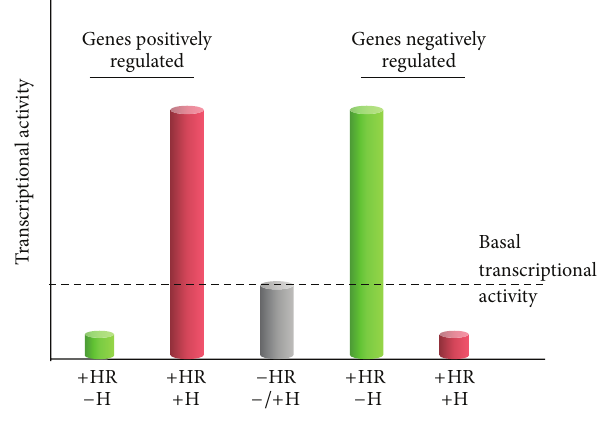
Figure 2: Diagram of transcription regulation by small-molecule hormones. H: hormone, HR: nuclear hormone